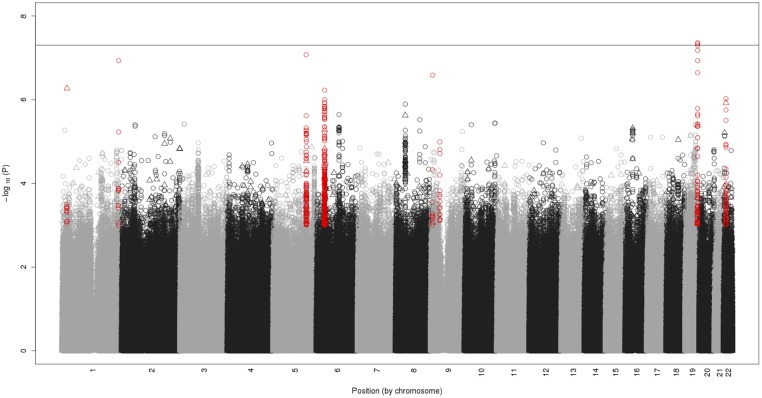
Manhattan plot showing the meta-analysis results of approximately 8 million SNPs and indels tested for association with HIV-1 acquisition in 2,004 African Americans and 1,132 European Americans from the Urban Health Study.The–log10 (P value) is plotted by chromosomal position of SNPs (shown as circles) and indels (shown as triangles). The SNPs and indels selected for replication testing from 8 gene regions are highlighted in red. The gene region above the solid grey line (P<5x10-8) exceeded the threshold for genome-wide statistical significance. In addition, the 6 gene regions above the dashed black line (P<1x10-6) and the region around the top genotyped SNP (P = 1x10-5 on chromosome 9) were selected for replication testing.